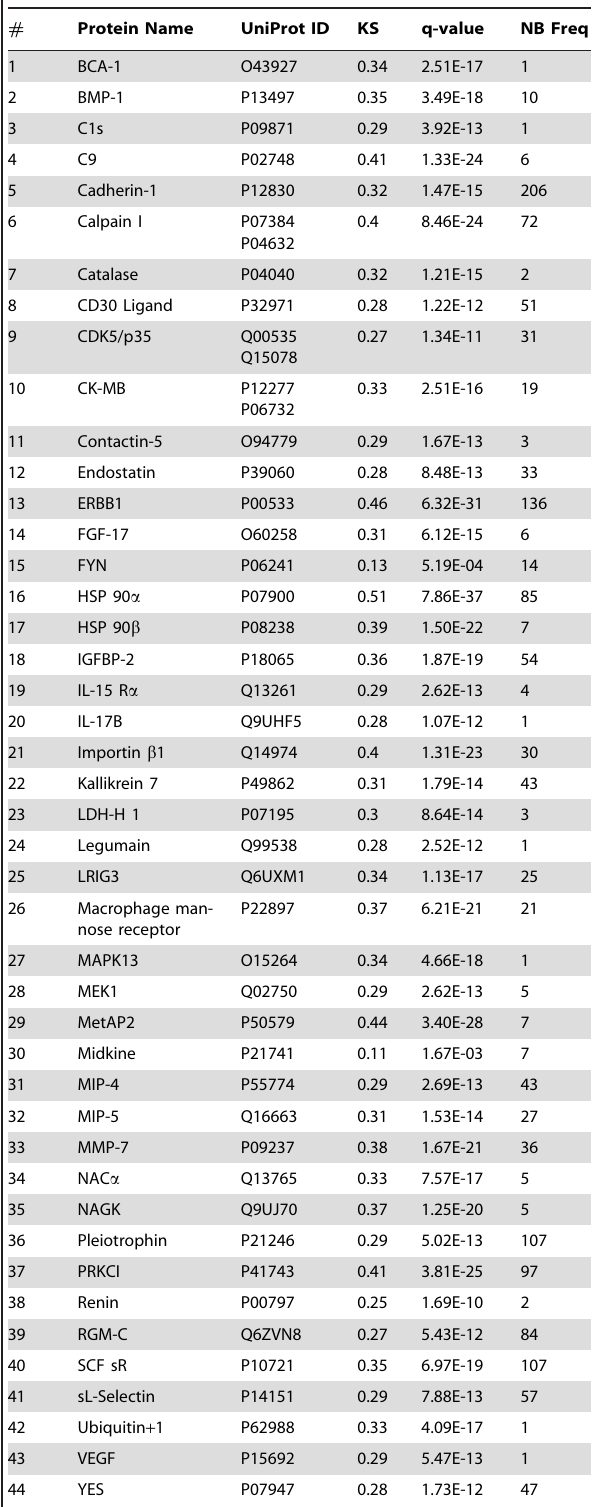
Table 4. Potential NSCLC biomarkers 1